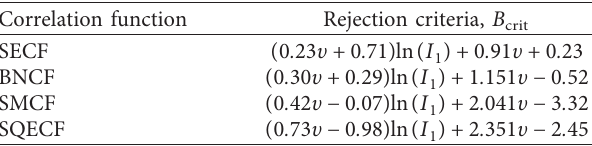
Table 2: Critical modified Bartlett test statistic at 5% level of significance for various common autocorrelation models ( I 2 � 1) (after